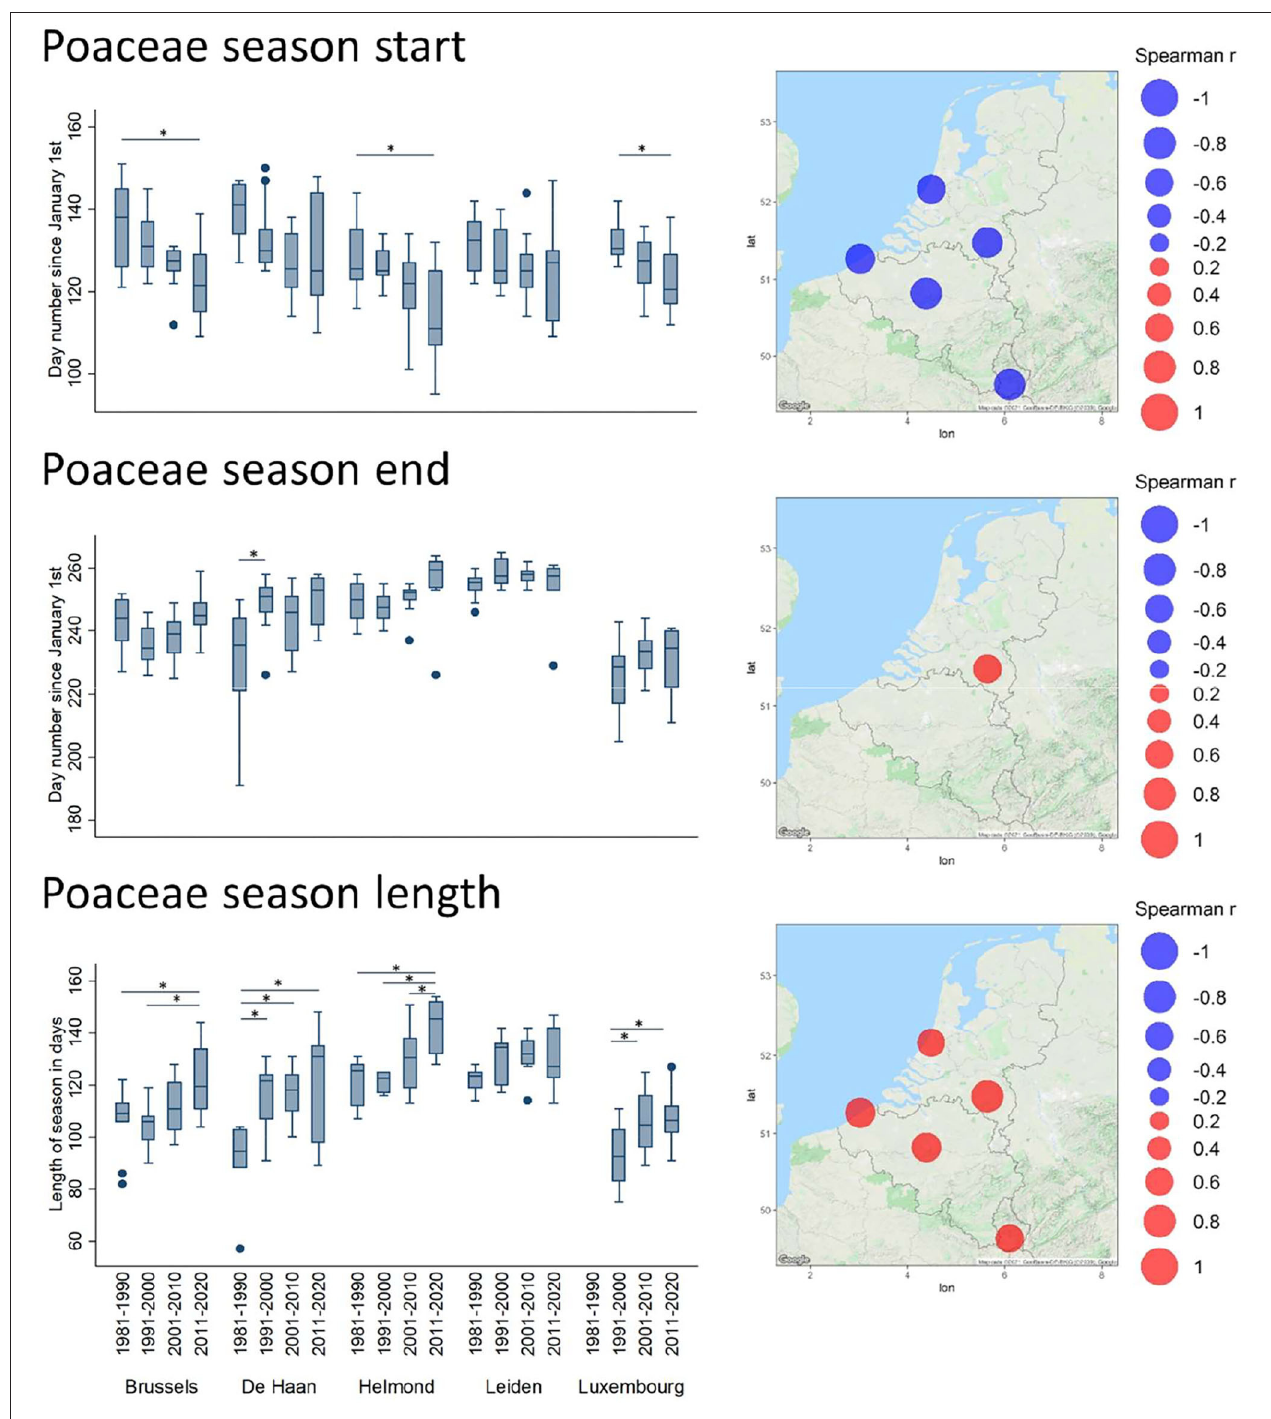
FIGURE 4 | Trends of timing shifts in pollen seasons for Quercus . Spearman correlation coefficient (Rho) values between the day of the year for the season start/end and years, and between season length and years, are plotted in bubble maps at the location of the monitoring stations, from negative (in blue) to positive (in red). The bubble size relates to the magnitude of the Rho value. Non-significant values are not shown on the maps. Timing parameters, averaged per decade (1981–1990, 1991–2000, 2001–2010, and 2011–2020), are depicted in boxplots. For further details, see legend of Figure 2 .